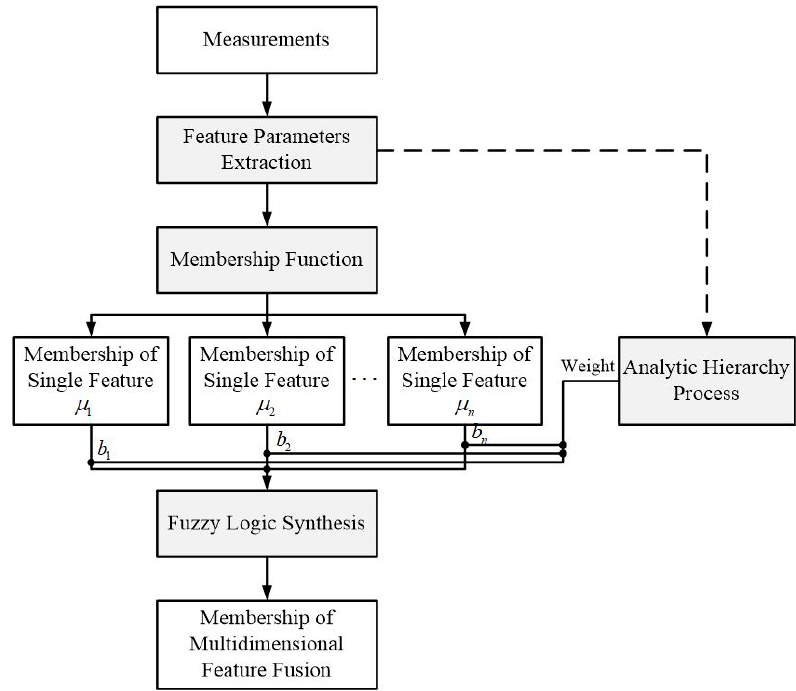
Figure 2. Principle diagram of the multidimensional feature fusion strategy.